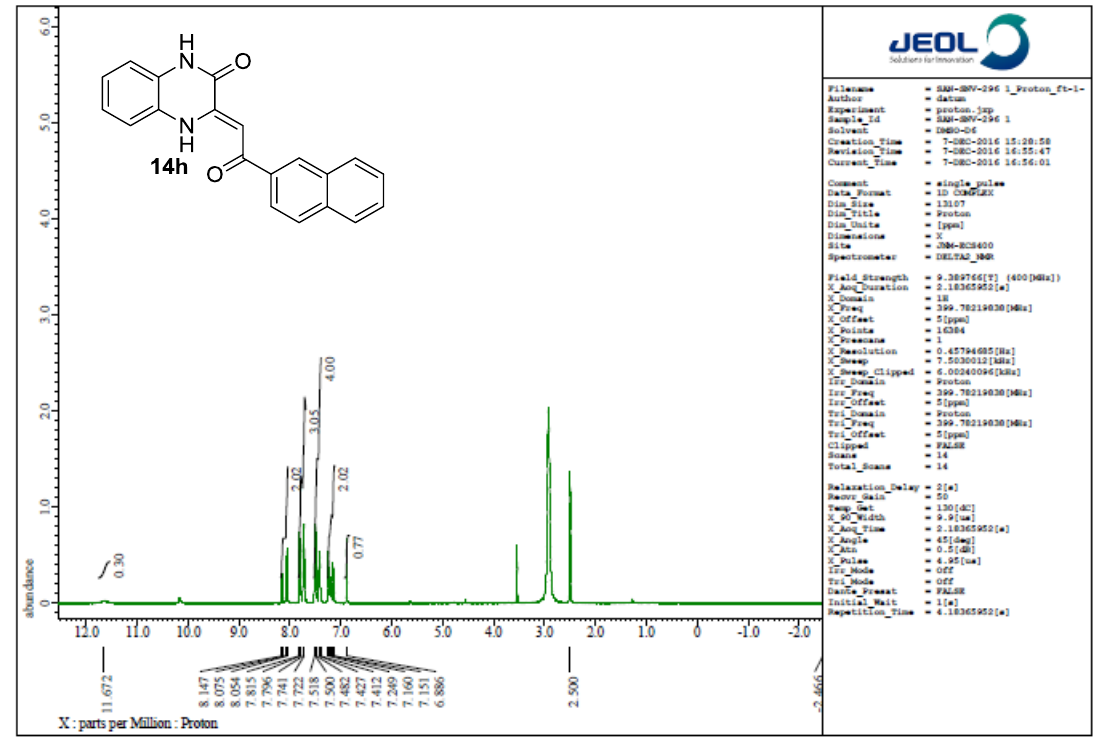
Figure 43 . 1 H NMR Spectra of Compound 14h .